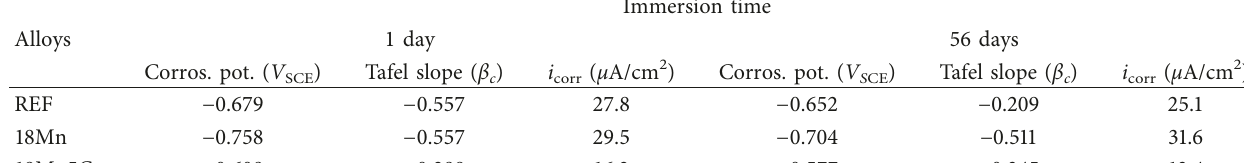
Table 4: Summaries on corrosion potentials, Tafel slopes, and corrosion rates of the experimental alloys from analysis of cathodic po- larization curves in Figure 2(b).